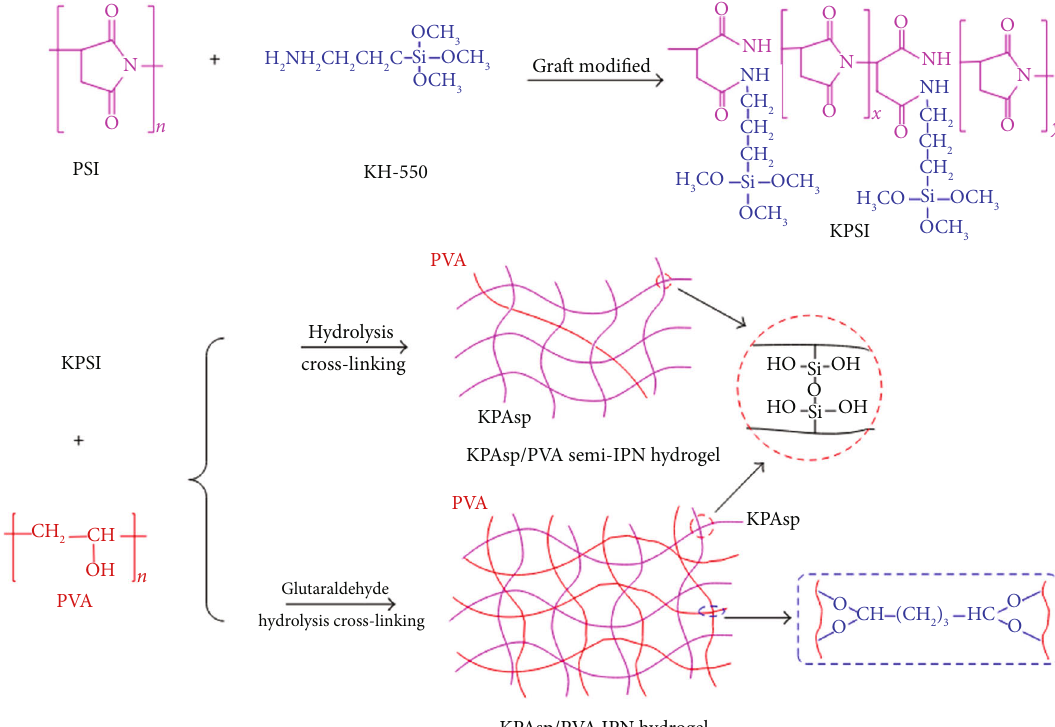
Figure 3: Illustrating the scheme of polyacrylamide characterized with cross-linked structure